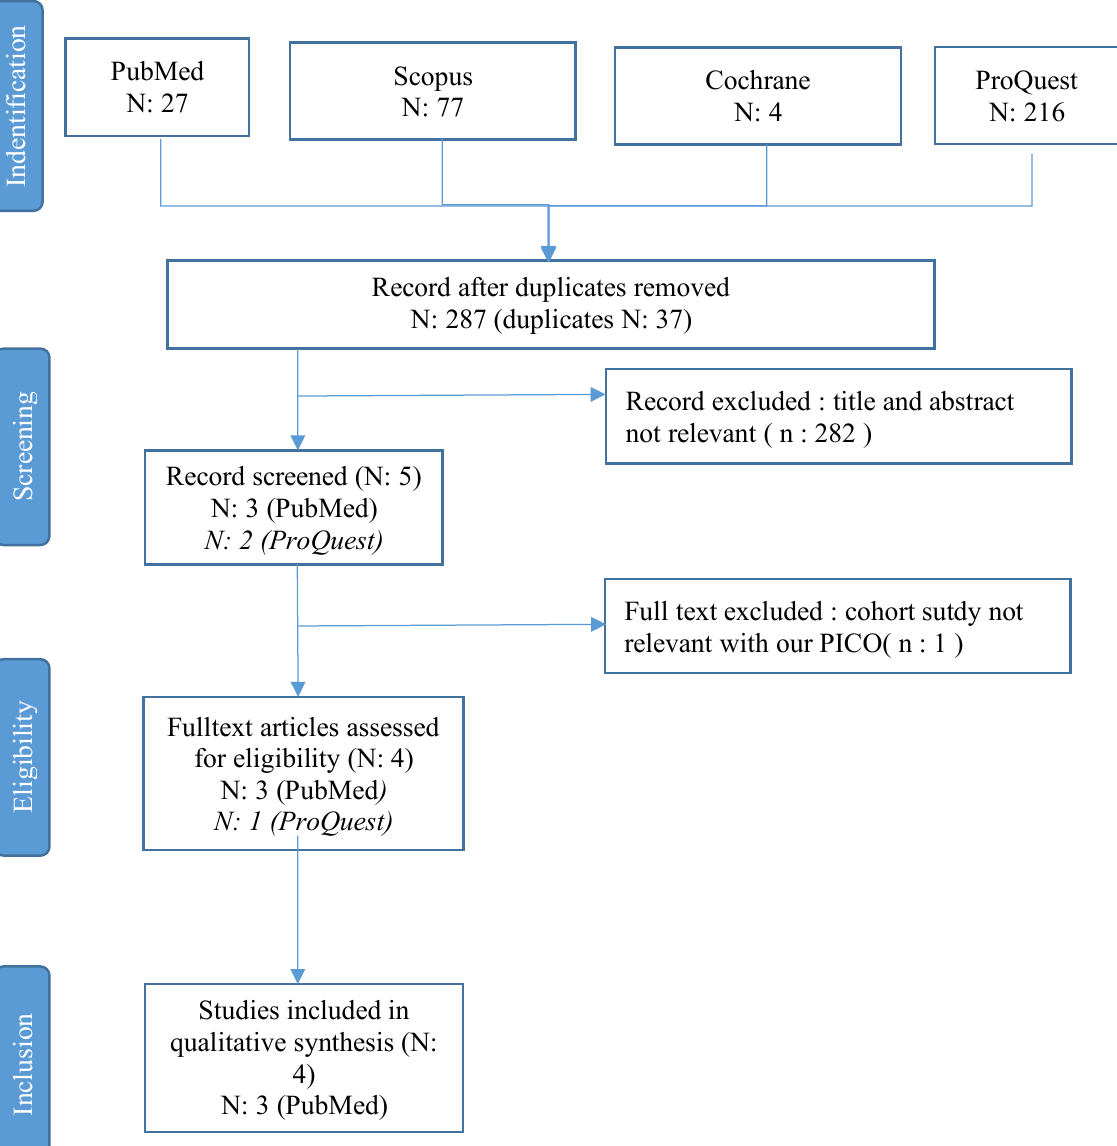
Figure 1. Prisma’s flow